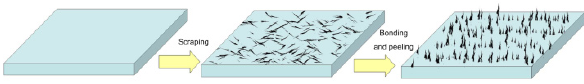
Figure 2: The schematic fabrication process of superhydrophobic polyolefin